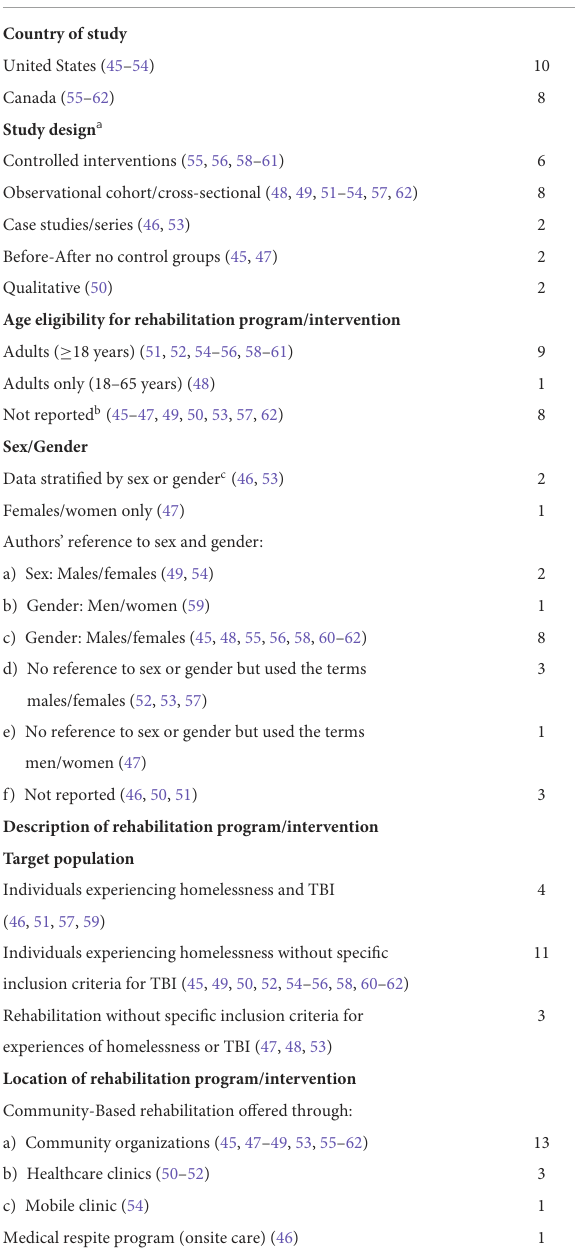
TABLE 2 Study characteristics and description of